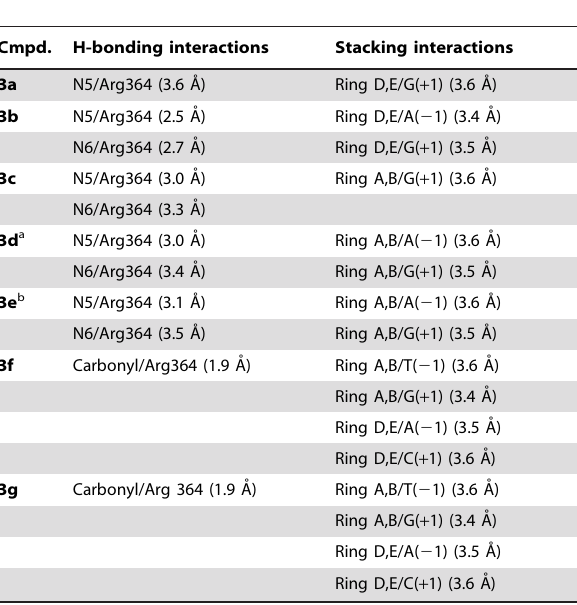
Table 3. Main interactions located for compounds 3a – g at their binding